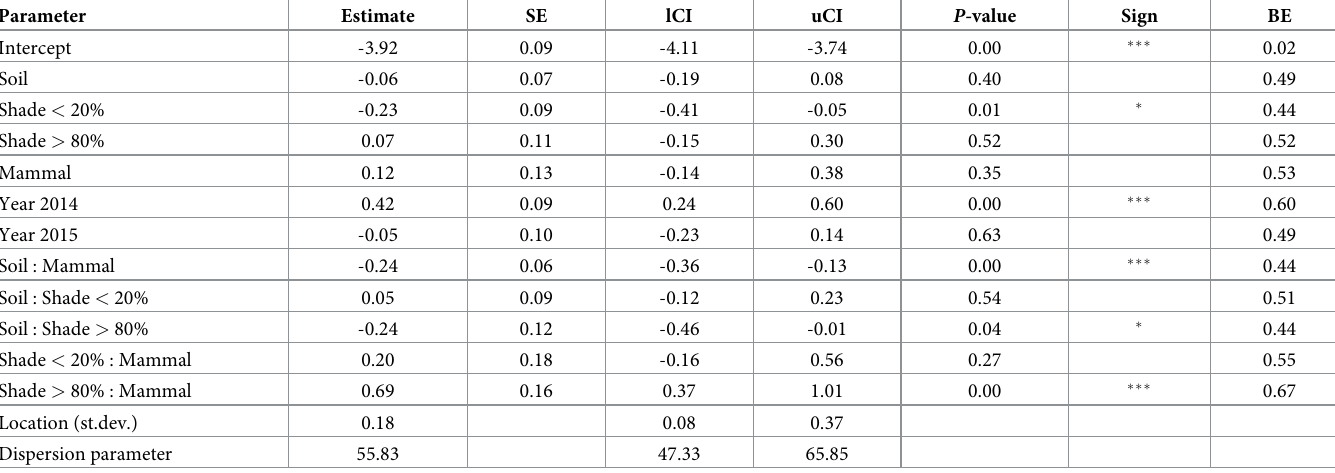
Table 1. Parameter estimates for the best model of variables affecting insect herbivory on bilberry leaves. Parameter estimate, standard error, 95% confidence interval and P -value are presented for the intercept and each of the fixed effects in the best model (S4 Table). Note that the model used a logit link function (the estimates are on a logit-scale, not the response scale), that the predictor variable previous mammalian herbivory was standardized and that the response variable was transformed prior to analyses (see text). Therefore, also the back-transformed estimate (back-transformed from both logit transformation and response variable transformation) is presented for the intercept and each of the fixed effects (thus, this value is on the response scale). Parameter estimate and 95% confidence interval are also presented for the standard deviation of the random component and for the dispersion parameter. Number of observations: 455.